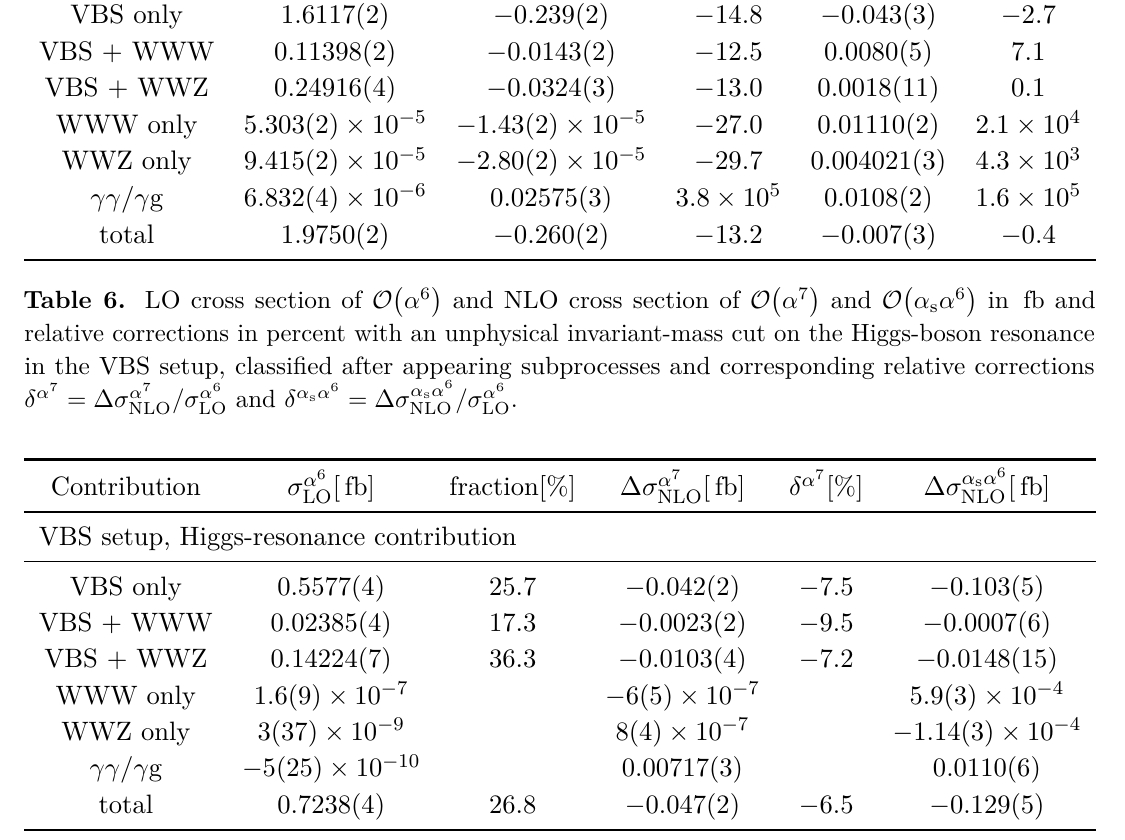
Table 7. LO cross section at corrections in percent, classified after appearing subprocesses, for the contribution of the Higgs resonance to the cross section σ Higgs = σ VBS setup Higgs-resonance contribution to the fiducial cross section σ Higgs /σ VBS setup at LO. We note the cancellations and correspondingly large relative combined integration errors in the subtraction for the contributions of the Higgs resonance to non-VBS processes, which lead to results that are compatible with